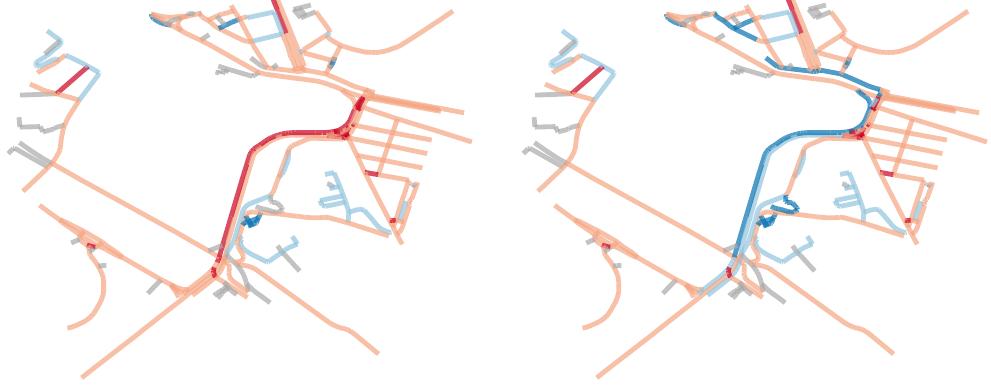
Figure 6. The road network in the central archaeological area as in the current situation (left) and in the project (right).